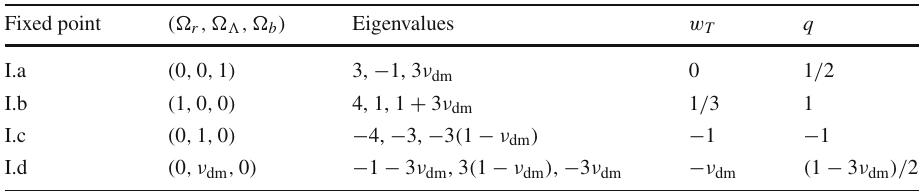
Table 2 Nature of fixed points of model I